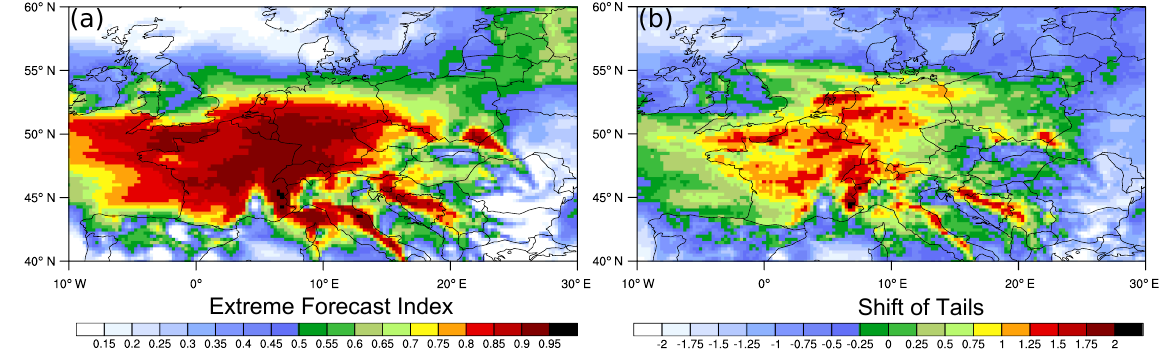
Figure 4. Example of the Extreme Forecast Index (a) and Shift of Tails (b) of daily maximum wind gusts for storm Lothar in the 6-day ensemble reforecast initialised on 21 December 1999 and valid on 26